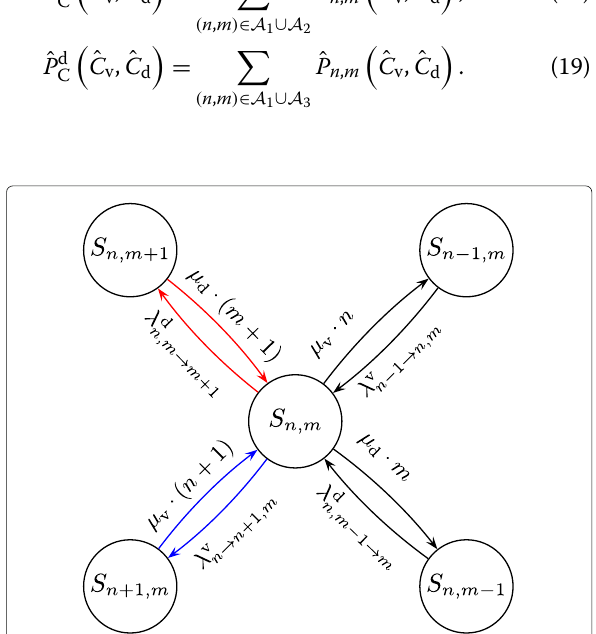
Fig. 3 Examples of the allowed states of the 2D M/M/m/m Markov